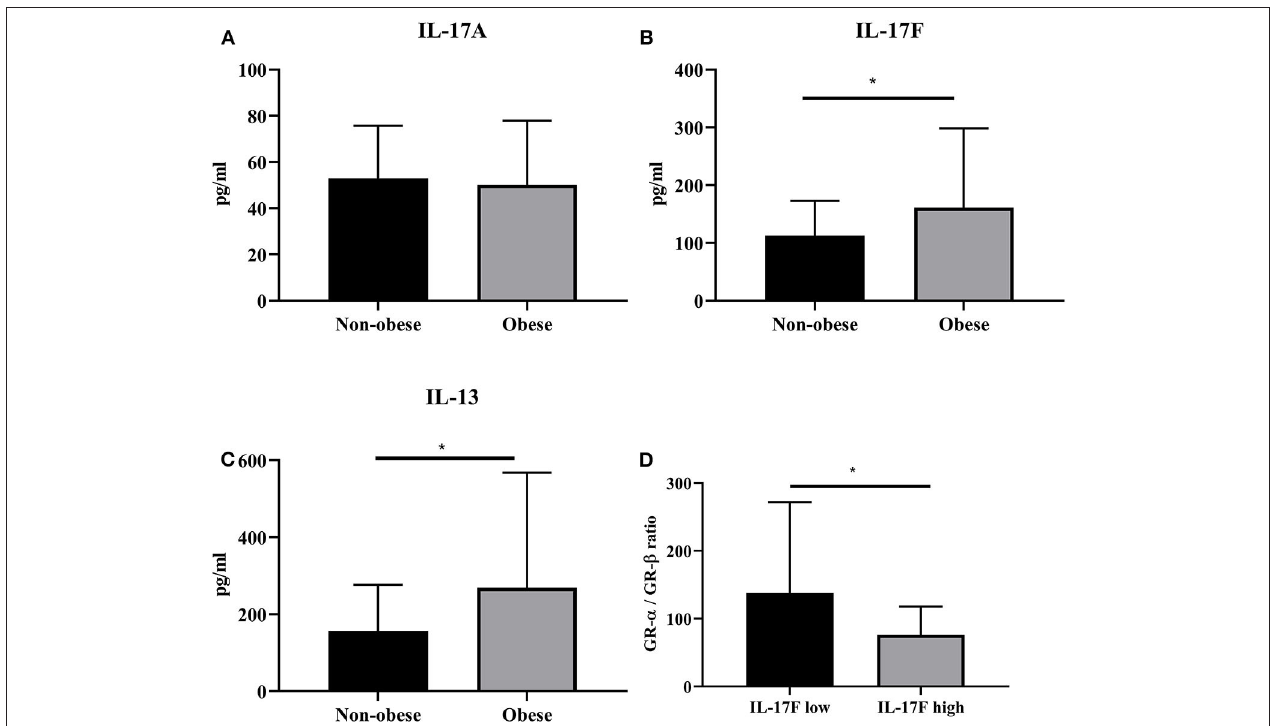
FIGURE 7 | IL-17F production is increased in serum of obese asthmatics. Serum was obtained from lean (BMI < 25 kg/m 2 ), overweight (BMI < 30 kg/m 2 ), obese (BMI < 35 kg/m 2 ), and morbidly obese (BMI > 35 kg/m 2 ) asthmatic subjects. (A–C) ELISA was used to assess protein levels of IL-17A, IL-17F, IL-13, respectively. (D) GR- α /GR- β ratio in subjects with high IL-17F and low IL-17F. n = 43 non-obese subjects, n = 57 obese subjects, Mean ± SE; * P <